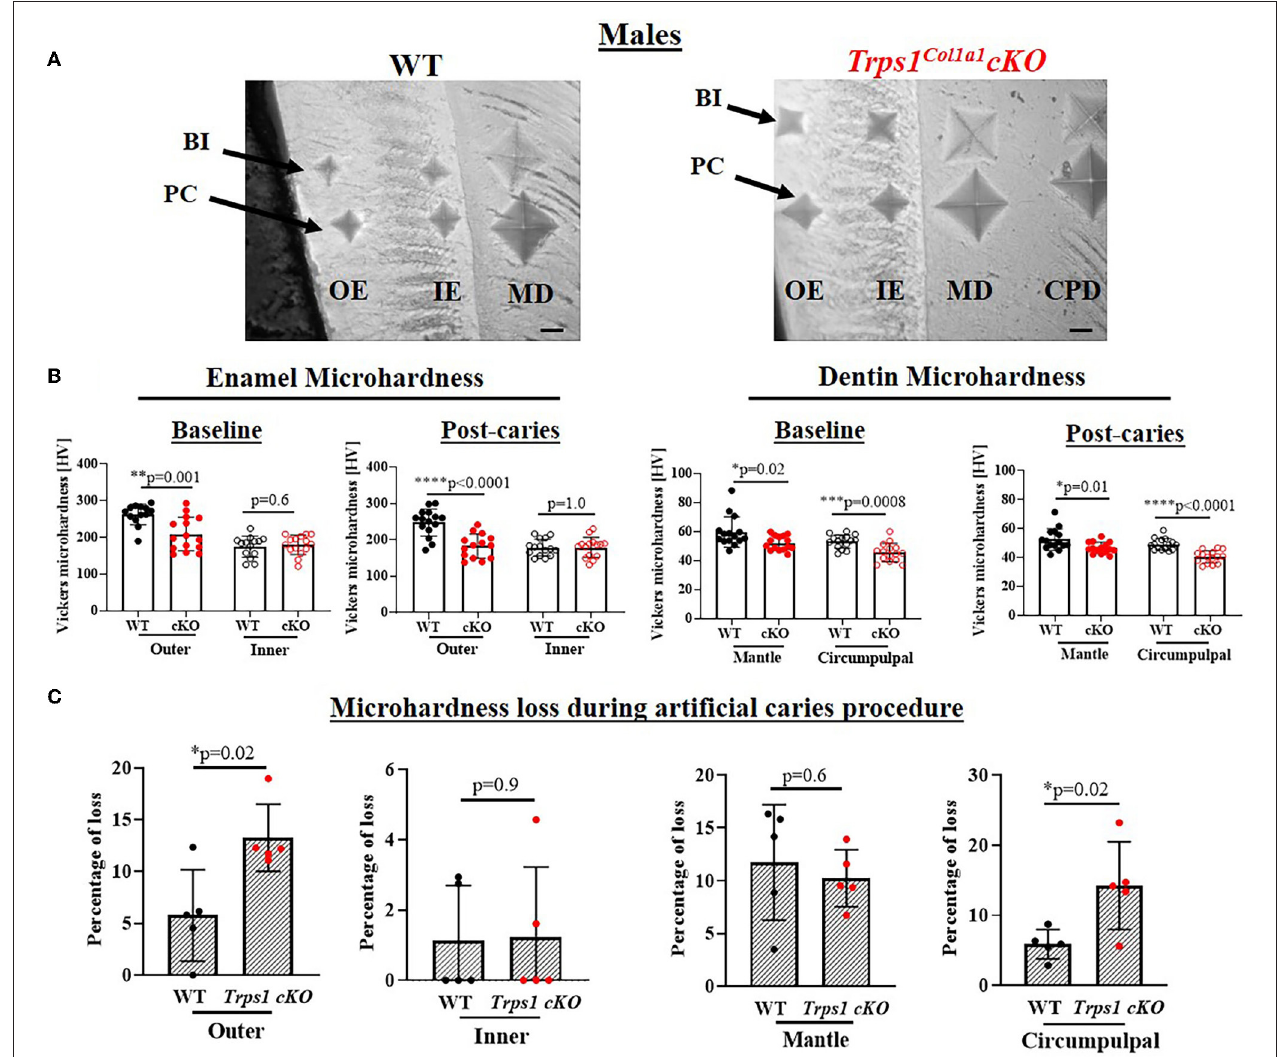
FIGURE 7 | Vickers microhardness analyses of enamel and crown dentin of mandibular first molars in 4 wk old WT and Trps1 Col1a1 cKO males. (A) Light microscopy images showing baseline indentations (BI), and indentations made after the artificial caries procedure (post-caries, PC) in the following regions: outer enamel (OE), inner enamel (IE), crown mantle (MD) and circumpulpal dentin (CPD); scale bar = 10 µ m. Three indentations (one per occlusal, middle, and cervical third of the crown) were made per region/molar. (B) Summary of the results of microhardness analyses of enamel and crown dentin. Data are shown as mean values of mechanical hardness (HV) ± SD and individual data points of all indentations performed in each region ( N = 5 molars/genotype, 3 indentations/region/molar), * p < 0.05, ** p < 0.01, *** p < 0.001 and **** p < 0.0001. (C) Graphs illustrating the percentage of microhardness loss during the artificial caries procedure. Data are shown as mean values of the % of microhardness loss ± SD and individual data points per mouse